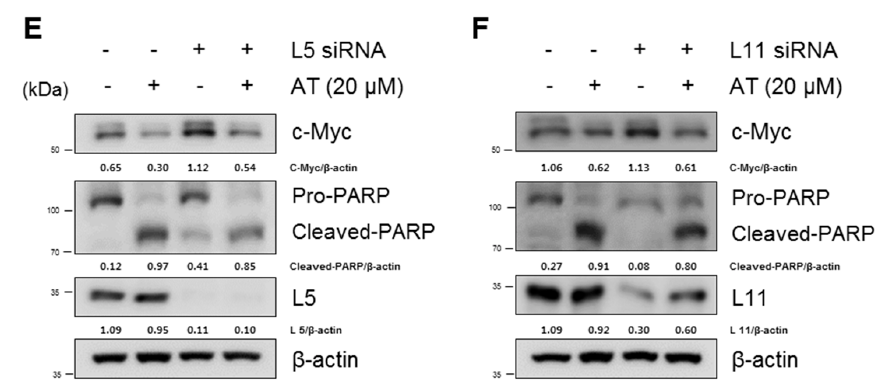
Figure 2. Atorvastatin induced apoptosis via ribosomal protein L5 and L11 in NSCLCs. ( A ) Effect of Atorvastatin on apoptotic bodies in H596, H460, and H1299 cells. The DAPI staining was used to detect apoptotic bodies in H596, H460, and H1299 cells treated with Atorvastatin (10 μ M). Arrows indicate apoptotic bodies. Bar scale = 20 μ m, DAPI-blue. ( B ) Effect of Atorvastatin on sub G1 population in H1299 cells. H1299 cells were treated with Atorvastatin (0, 5, 10, and 20 μ M) for 48 h and stained with propidium iodide (PI) after fixation. Stained cells were analyzed using a FACS Vantage flow cytometry system. ( C ) Effect of Atorvastatin on PARP in H596, H460, and H1299 cells. The cells were exposed to Atorvastatin (10 μ M) for 48 h and subjected to Western blotting with antibody of PARP. ( D ) Effect of Atorvastatin on PARP, caspase 3, p53 and β -actin in H596, H460, and H1299 cells. The cells were exposed to Atorvastatin (10 μ M) for 48 h and subjected to Western blotting with antibodies of PARP, caspase 3, p53 and β -actin. ( E , F ) Effect of Atorvastatin on c-Myc, PARP, L5, L11, and β -actin in H1299 cells transfected with or without L5 siRNA or L11 siRNA plasmid. The cells were exposed to Atorvastatin (20 μ M) for 48 h and subjected to Western blotting with antibodies of c-Myc, PARP, L5, L11, and β -actin.